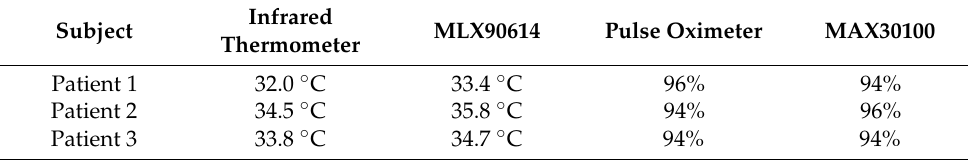
Figure 9. Final working prototype, ( a ) external packaging, and ( b ) internal structure. Table 7. Body temperature and SpO 2 sensor performance testing.